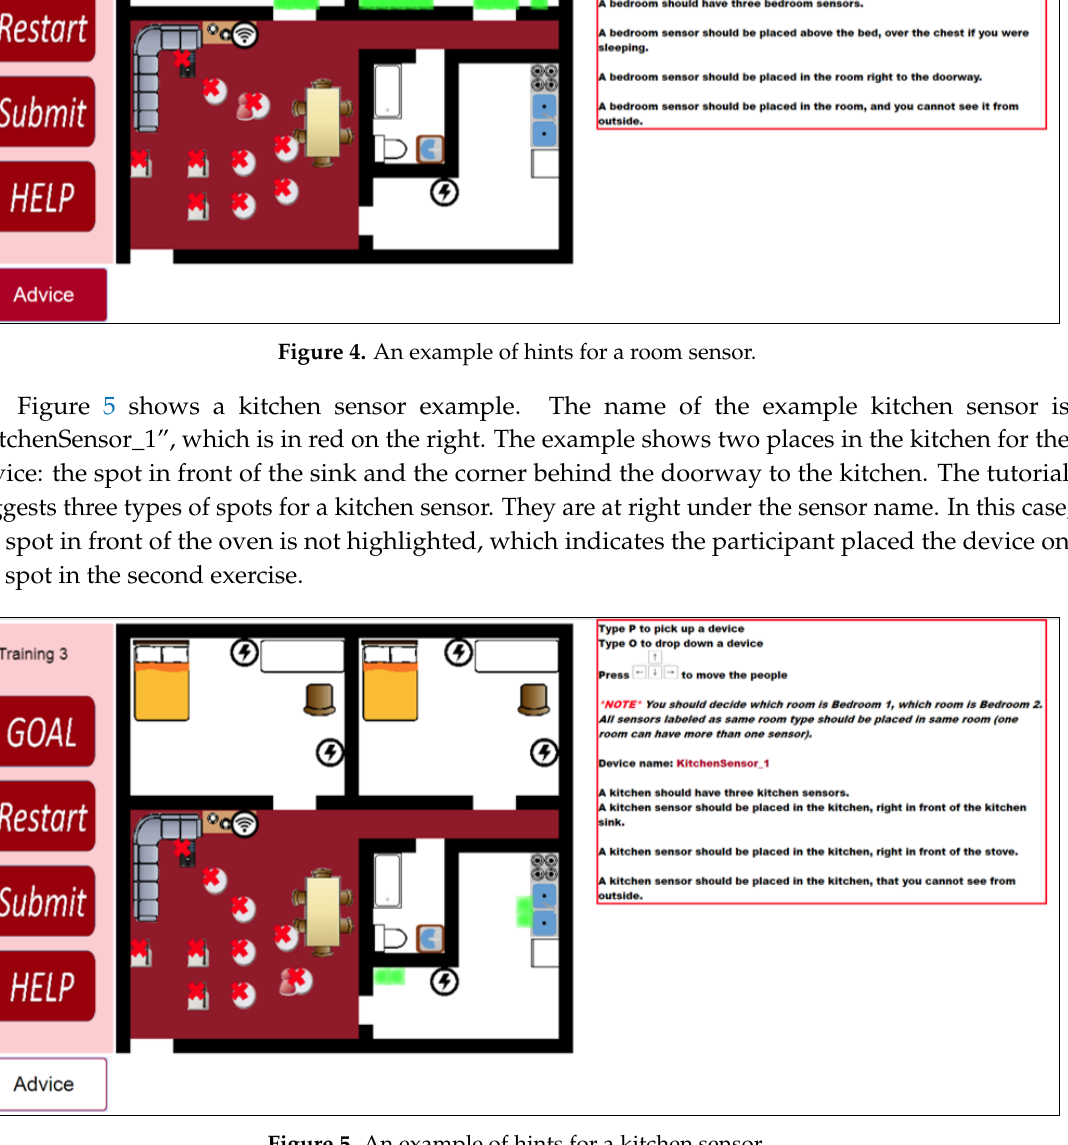
Figure 5. An example of hints for a kitchen